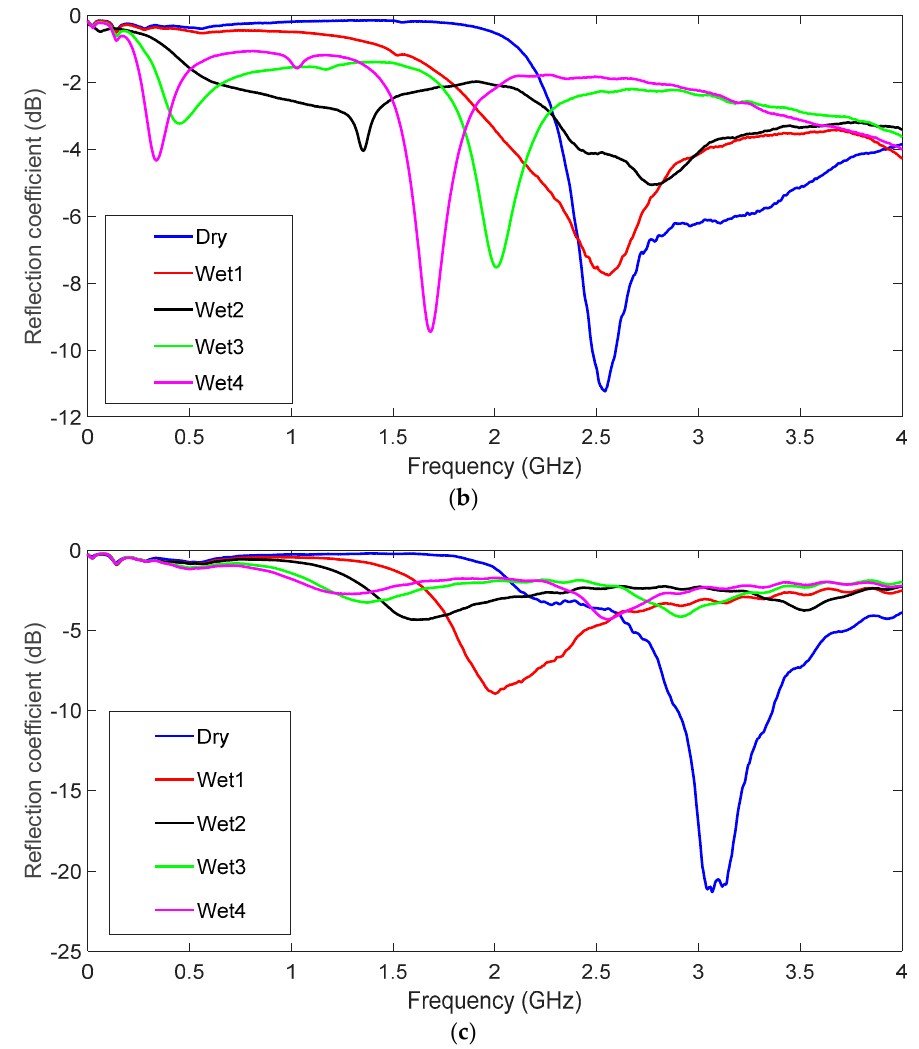
Figure 12. Measured Reflection coe ffi cient for the di ff erent values of the water in the prototype with Figure 12 . Measured Reflection coefficient for the different values of the water in the prototype with several felt thicknesses. ( a ) hs = 2 mm, ( b ) hs = 6 mm and ( c ) hs = 10 mm. several felt thicknesses. ( a ) hs = 2mm, ( b ) hs = 6mm and ( c ) hs = 10mm.